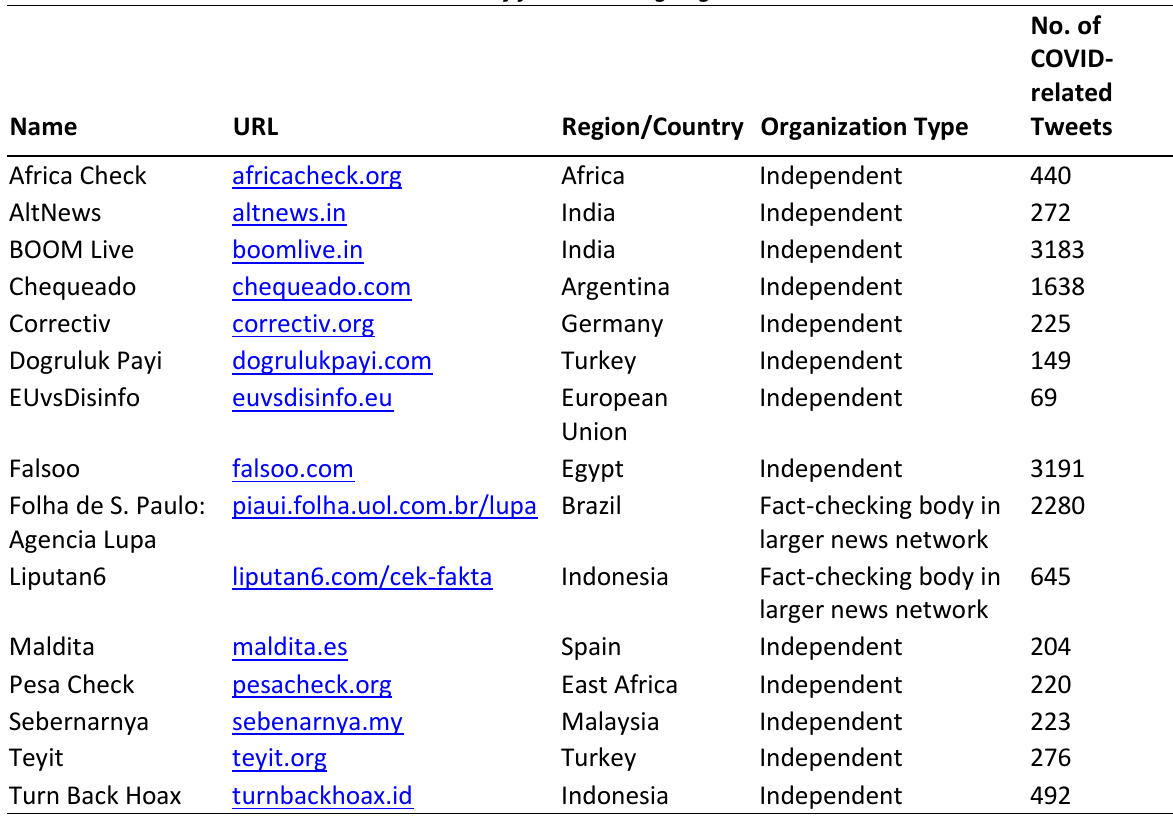
Table 1. List of fact-checking